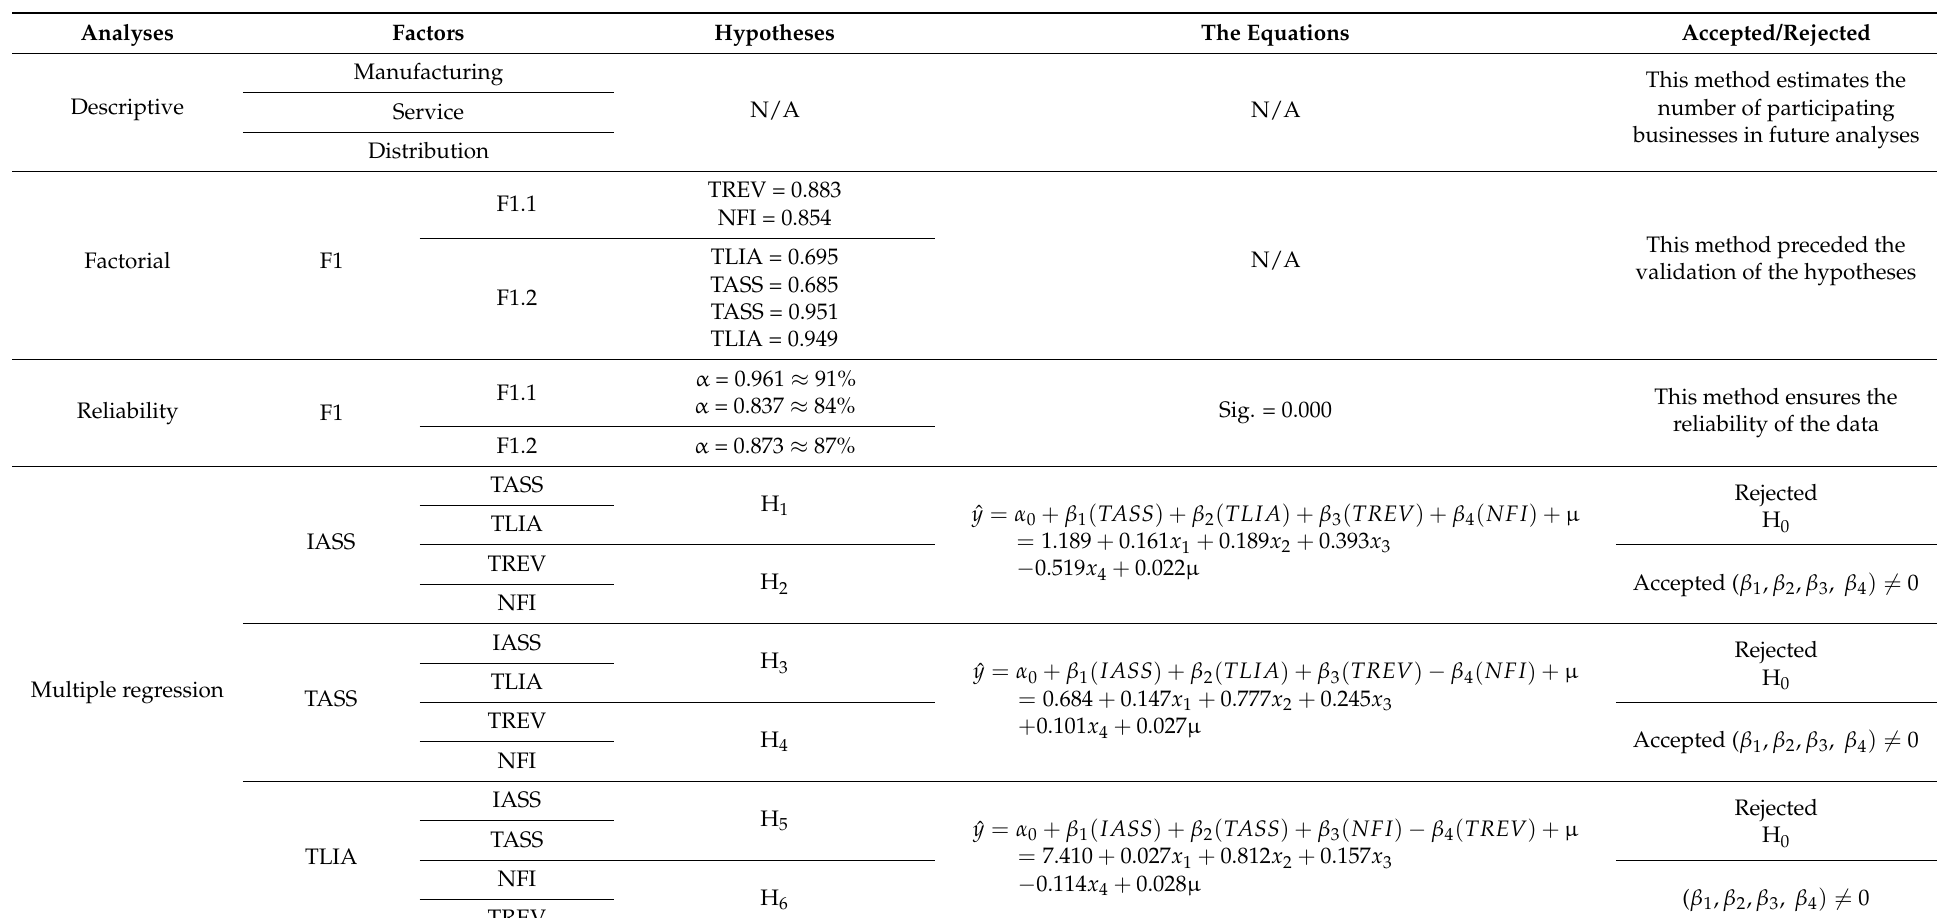
Table 14. Approval of hypotheses for all